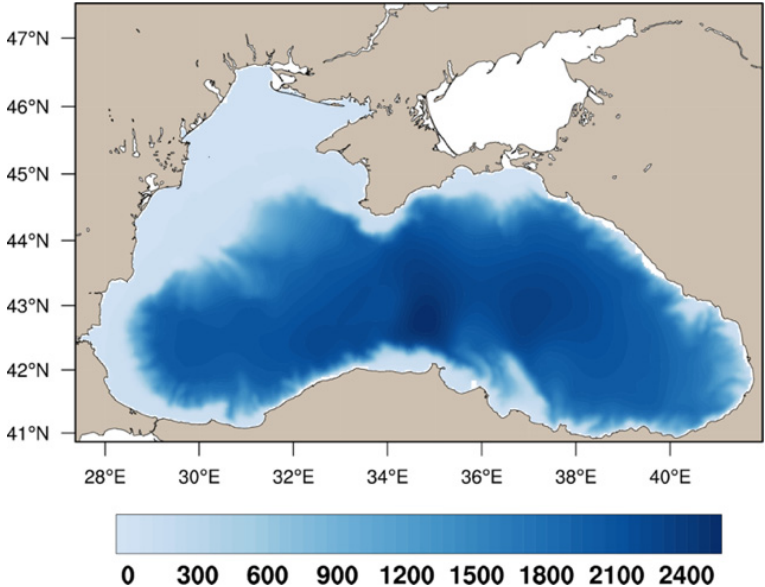
Figure 1. Black Sea spatial domain and bathymetry (in meters).